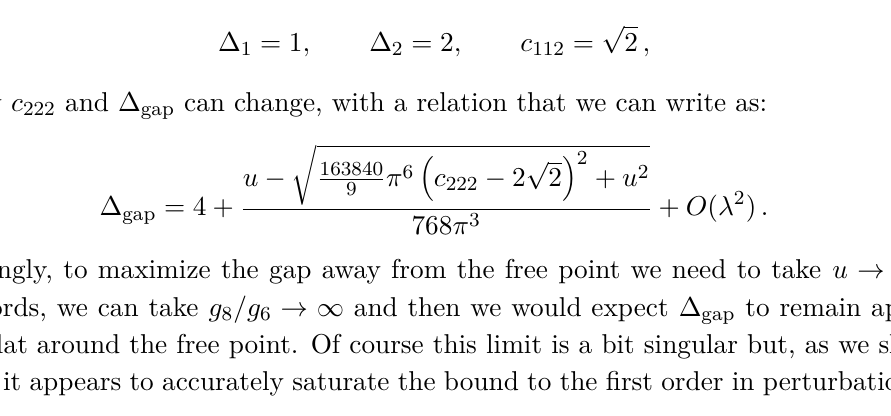
Figure 9 . The maximal value of the gap as a function of c 222 with (∆ 1 , ∆ 2 , c 112 ) as given, which to first order corresponds to switching on only the g 6 deformation. The numerical bound appears to converge to the horizontal line ∆ gap = 4 . The free theory can only explain this bound at the single red point. We can venture away from this point by switching on g 6 , but to obtain the blue line we need to simultaneously turn on a much larger φ 8 interaction. Notice that the best bound (in black) corresponds to Λ = 50 , whereas the gray bounds correspond to Λ = 30 and Λ = 40 . The g 6